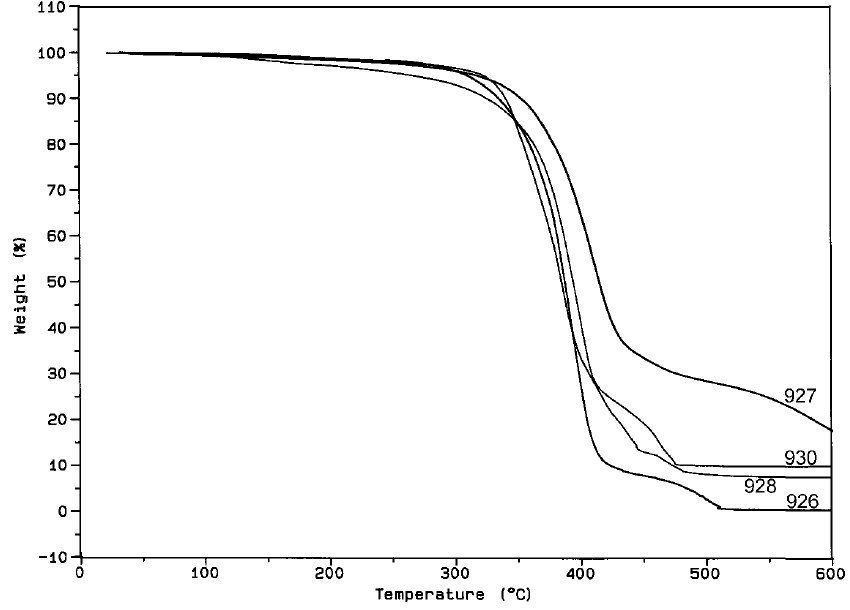
Fig. 1 TGA diagram of products with PEtA (s.926: PEtA; s.927: PEtA+TIP+ VTES; s.928: PEtA+TIP+OTES; s.930: PEtA+TIP); s. = sample